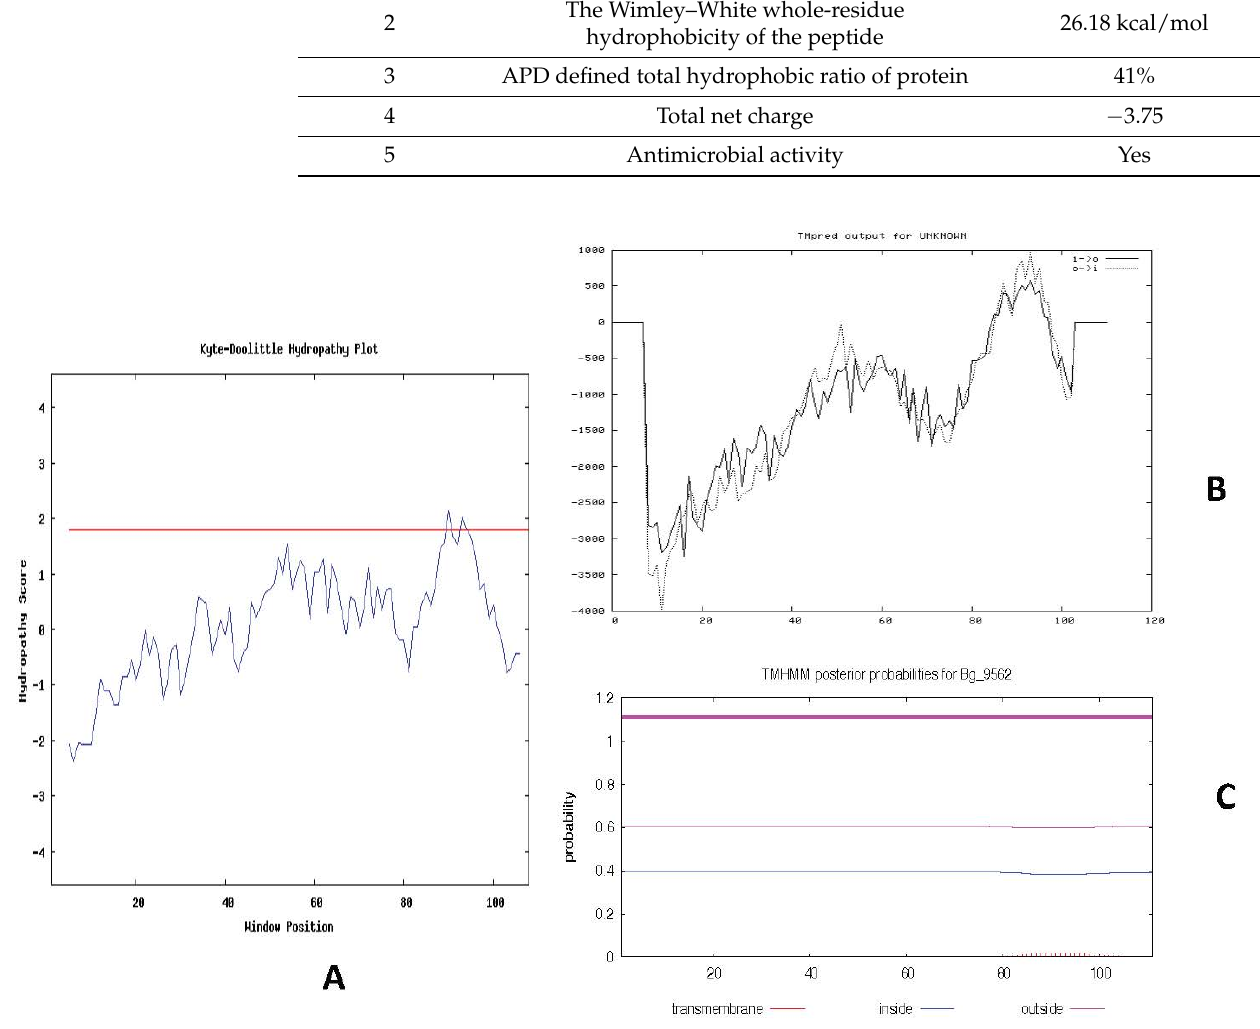
Figure 4. Hydropathy plot constructed for Bg_9562 protein and prediction of transmembrane region of Bg_9562. ( A ) Kyte–Doolittle hydropathy plot was constructed with 103 effective amino acids and with the window size of 9. The peaks above the red line (~1.8) in the graph indicate possible transmembrane regions in the protein. ( B ) The output of TMPred analysis shows presence of single strong transmembrane helices with 83–102 residues of Bg_9562 protein. ( C ) Prediction of transmembrane region with high probability using TMHMM software. Table 2. List of various parameters of Bg_9562 predicted using Antimicrobial Peptide Database (APD)-based prediction.